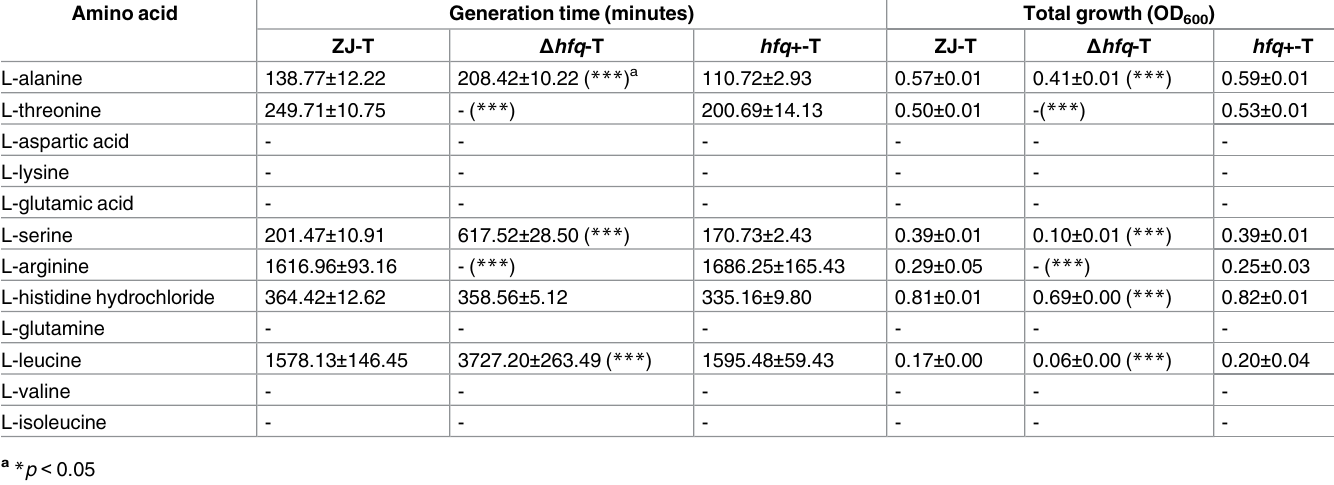
Table 3. Effect of hfq deletion on growth rates and total growth in minimal medium M63 supplemented with various amino acids as both carbon and nitrogen sources. Values correspondto the mean of three independent cultures. Significant statistical differences between strains and WT are